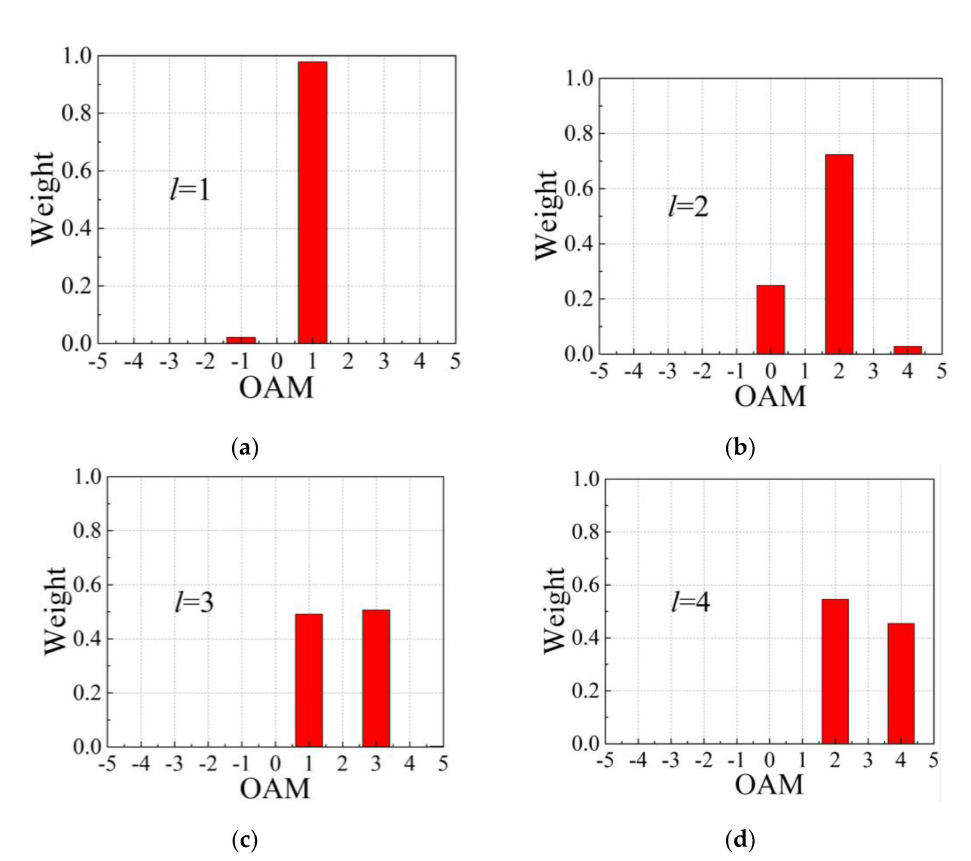
Figure 10. The same as in Figure 7, but the measurement plane is located at z = 1000 µ m. Table 2. Relative error in the detection probability of the OAM modes for scattered fields at z = 50 µ m and z = 1000 µ m of the beam with topological charge l . The scatterer is a uniform and isotropic dielectric